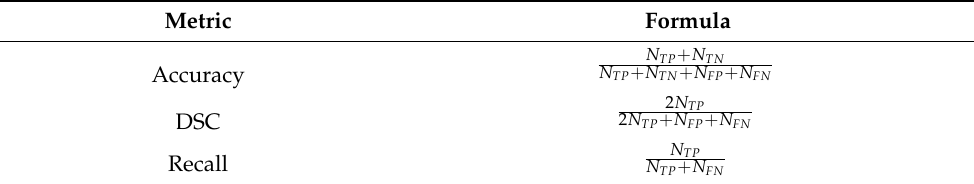
Table 1. Definitions of the evaluation metrics.